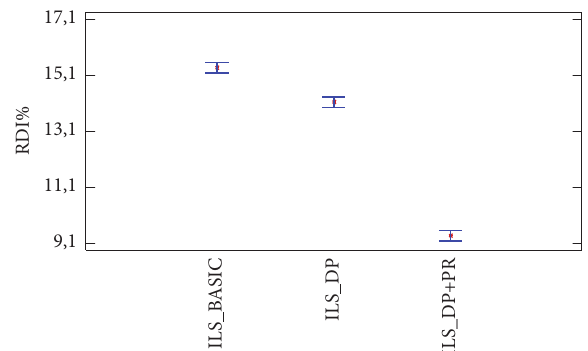
Figure 6: Means plot and Tukey’s HSD intervals at 95% confidence level for heuristics ILS BASIC, ILS DP, and ILS